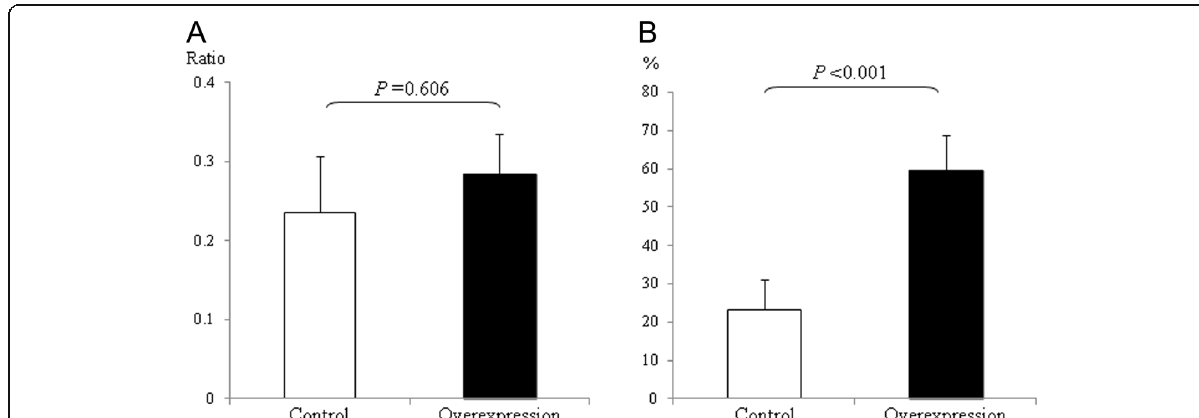
Fig. 5 Overexpression of the NCTIN4 gene in HTR-8 cell lines. a Invasion assay. Vertical axis indicates the ratio of cells invading through the matrigel membrane to those migrating through the control membrane. b NK cell cytotoxicity assay. Vertical axis indicates the percentage cytotoxicity calculated using an LDH cytotoxicity assay. Data obtained from control HTR-8 cells (open bars) versus HTR-8 cells overexpressing nectin-4 (black bars) were compared. Each bar represents the mean value. Error bars indicate the standard